Question: From the figure, is the trend upward or downward?
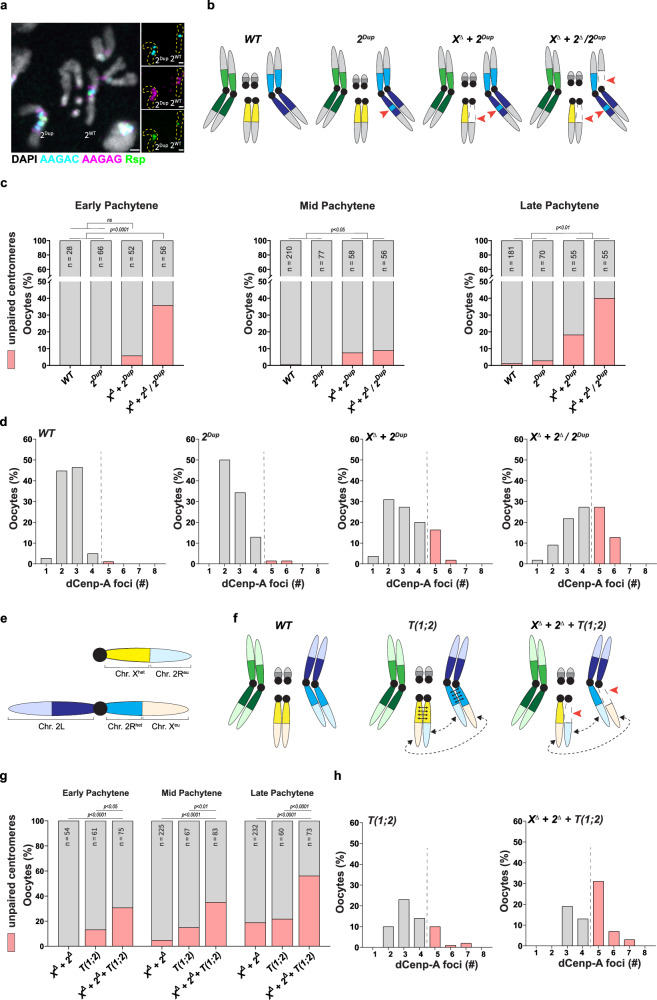
Answer: increasing